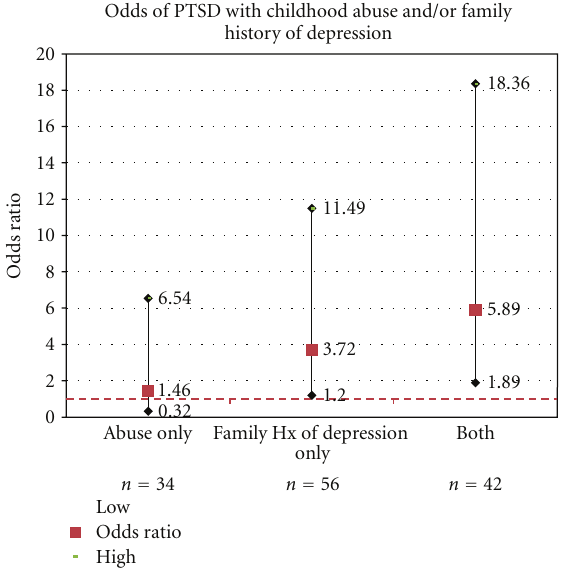
Figure 1: Odds ratios for risk of developing PTSD in the context of a family history of major depressive disorder and childhood abuse.